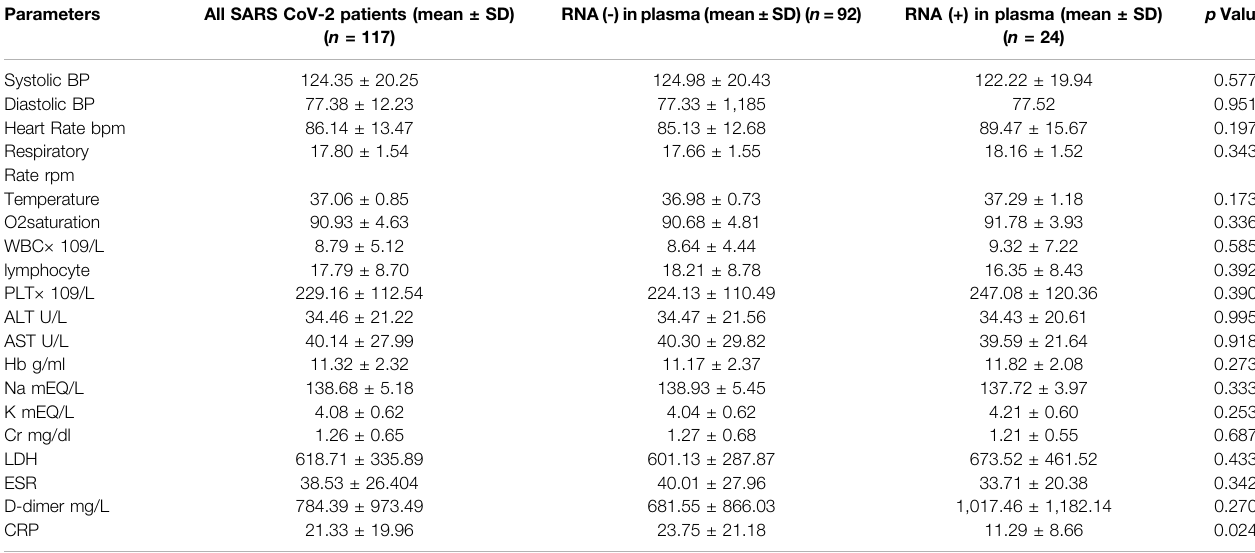
TABLE 4 | Laboratory Parameters of COVID-19 patients with plasma on admission. Parameters All SARS CoV-2 patients (mean ± SD) RNA(-)inplasma(mean±SD)( n ( n = 117)